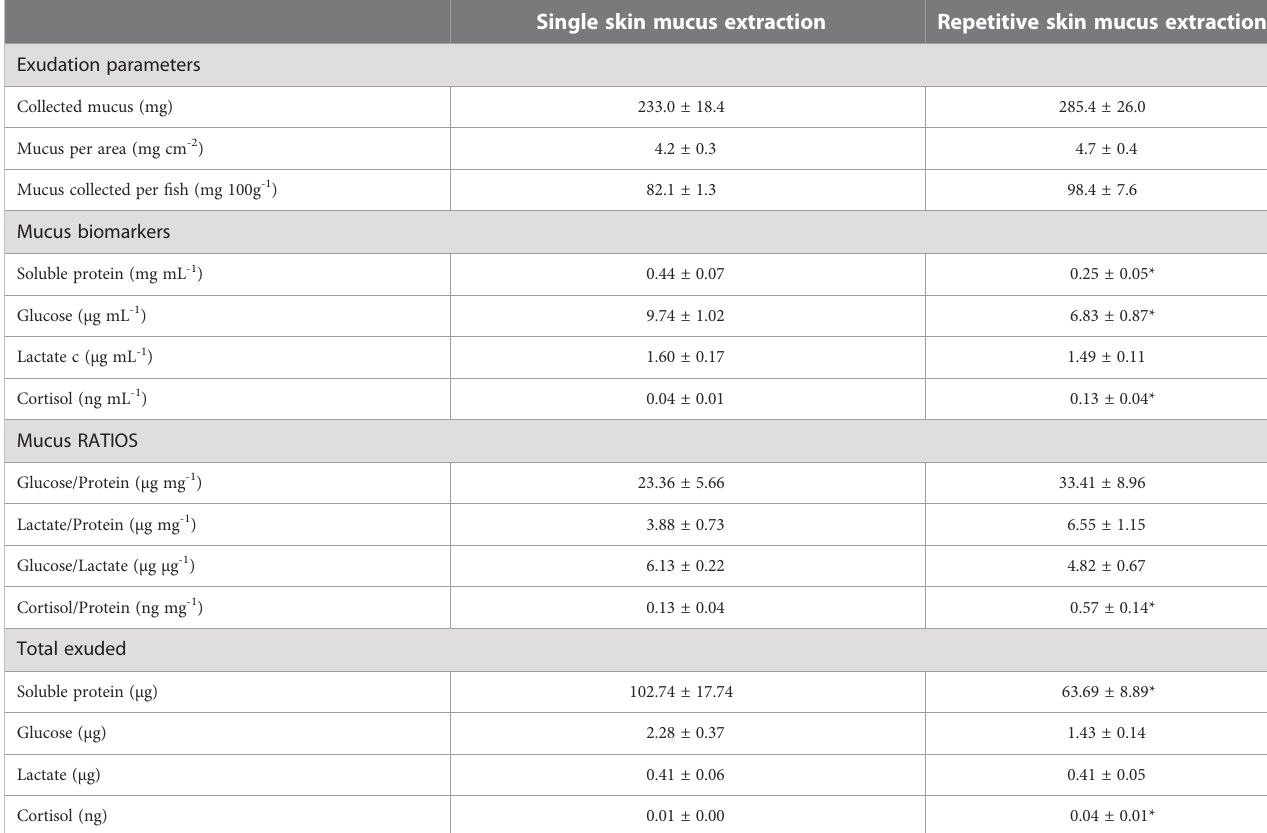
TABLE 1 Exudation parameters and Skin Mucus-Associated Biomarkers (SMABs) of gilthead sea bream skin mucus subjected to single or repetitive